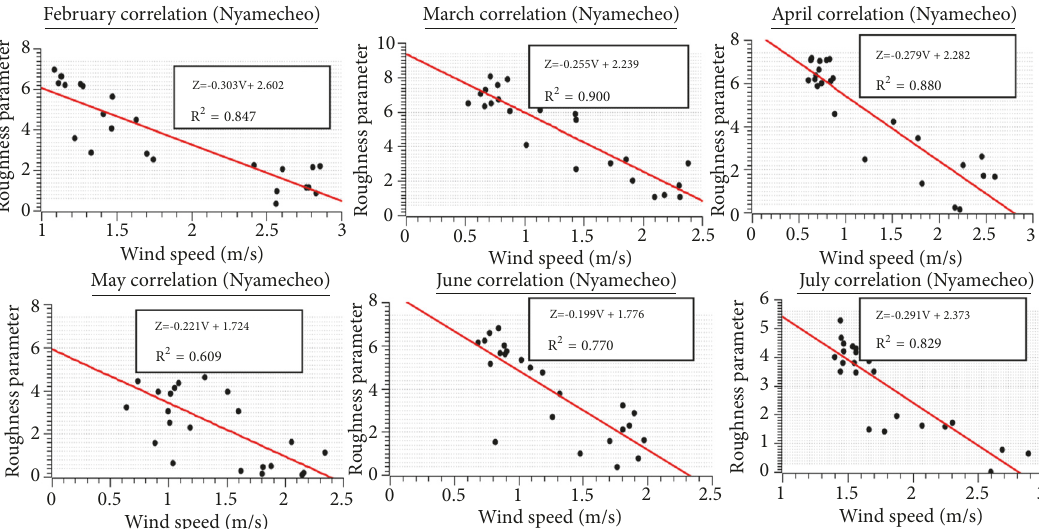
Figure 10: Correlation of wind speeds and roughness parameter for Nyamecheo